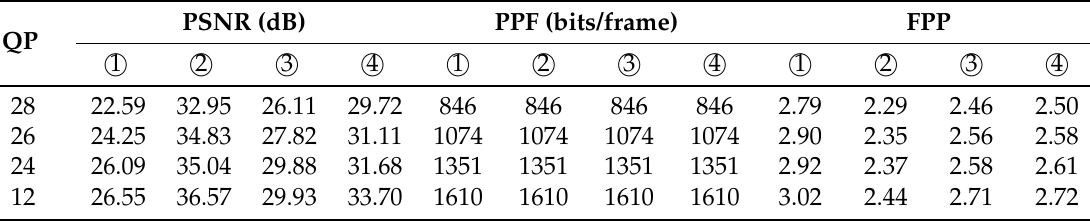
Table 3. The performance comparison between various V u